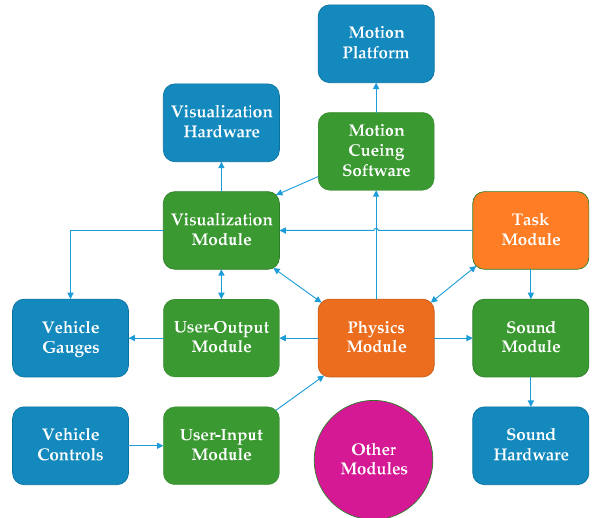
Figure 1. Scheme of the components of a vehicle simulator.